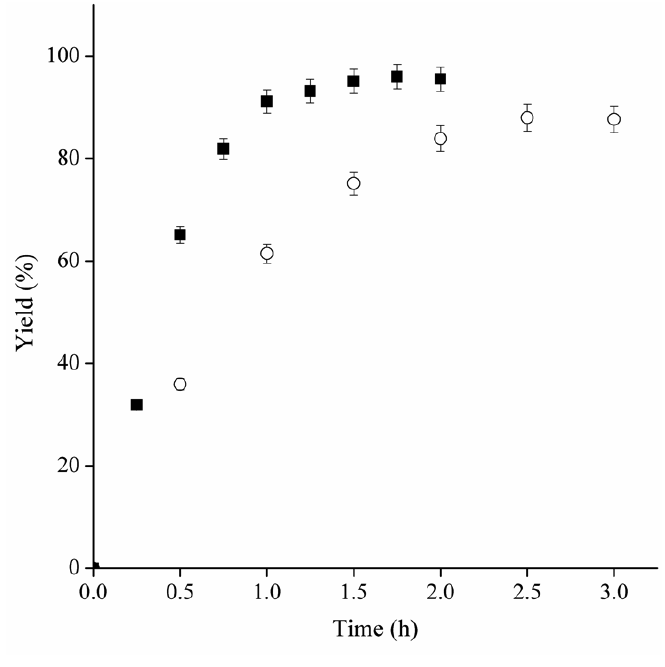
Figure 4. Time course of ultrasound-assisted butyl acetate synthesis catalyzed by MCI- CALB under condition I (temperature, 48.8 °C; substrate molar ratio, 3.46:1 alcohol:acid; amount of biocatalyst, 7.5%; and added water 0.28%) at (  ) 2.0 M and (  ) 0.3M acetic